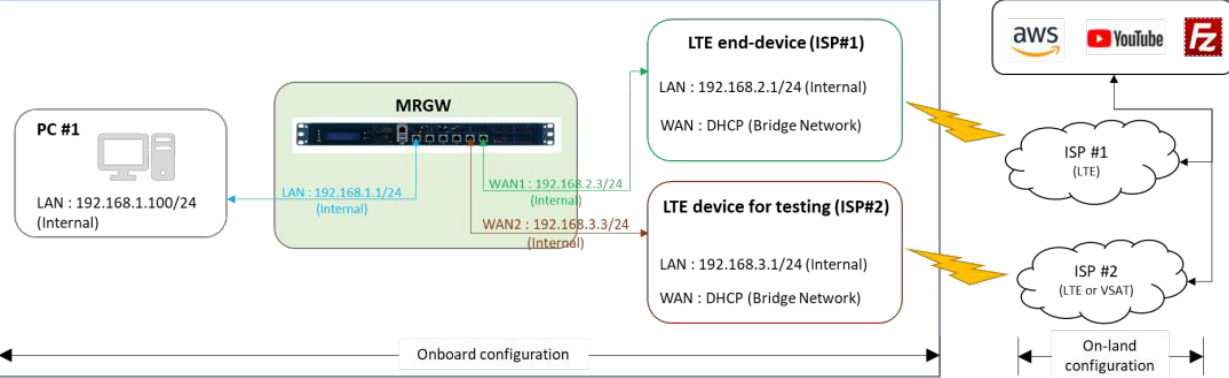
Figure 10. System configuration for the test scenario 1 for evaluating the switchover performance of MRGW.